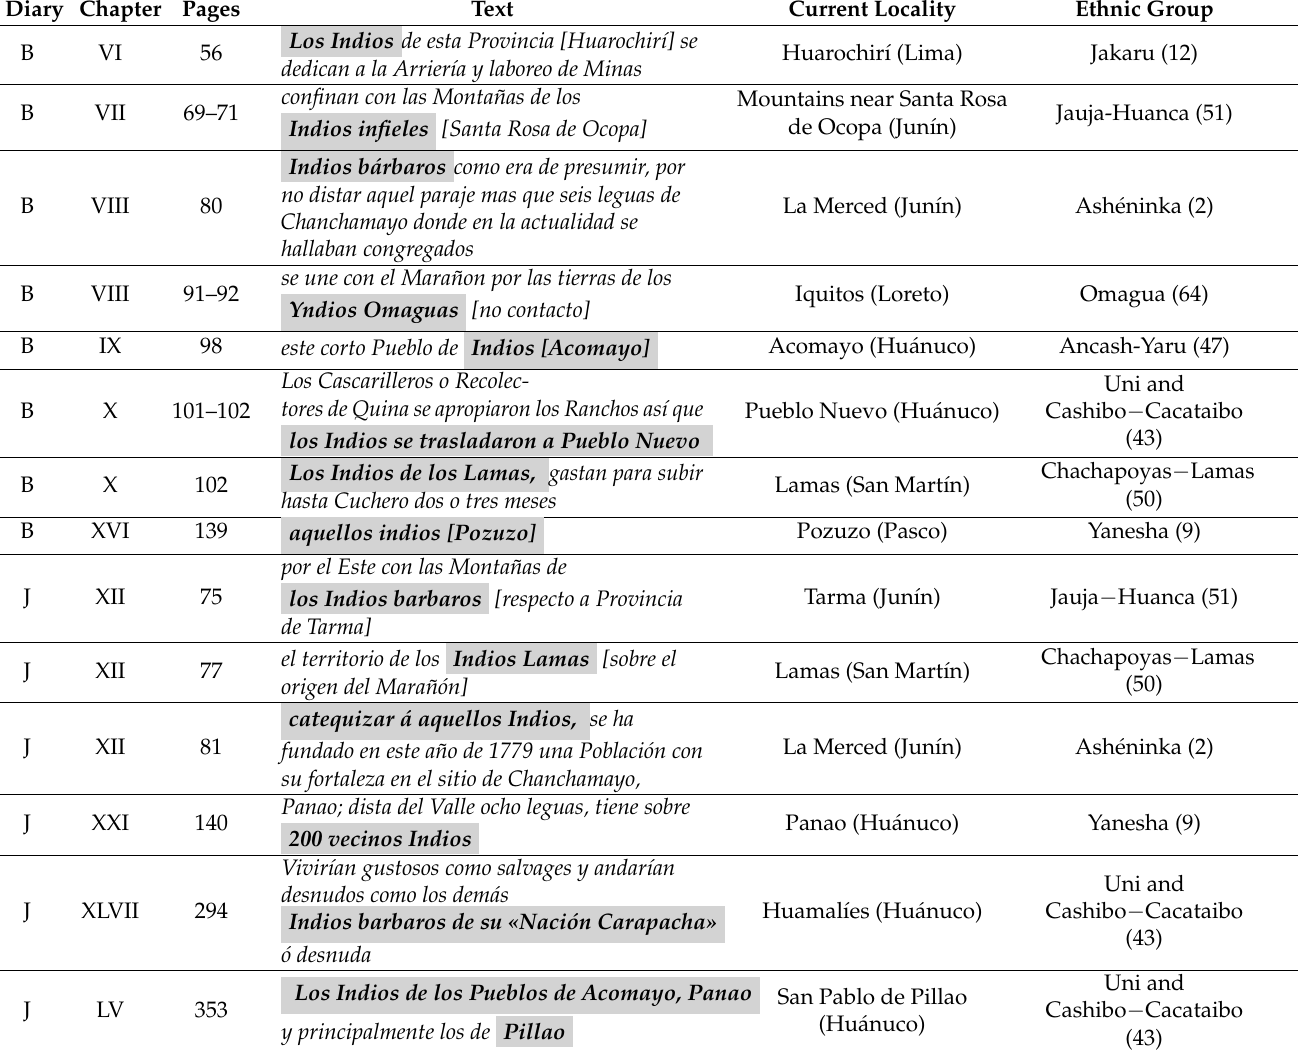
Table 3. Correspondence between some texts from the diaries, current localities and ethnic groups. Current